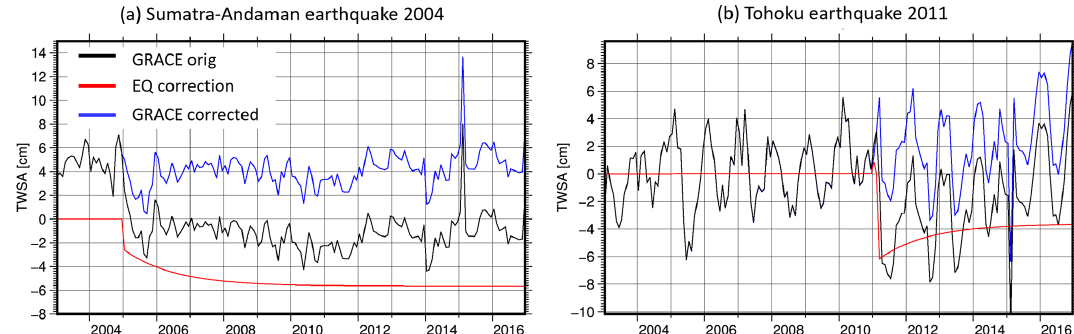
Figure 8. Spatially averaged GRACE TWS anomalies for the original (black) and earthquake-corrected (blue) GRACE data and its correction (red) for (a) peninsular Malaysia (West Malaysia) and (b)